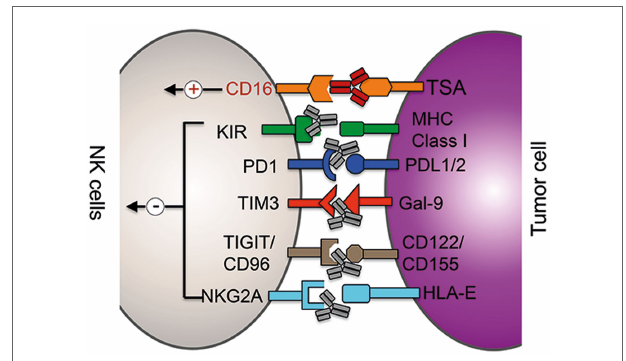
FiGURe 1 | Clinical and preclinical therapies augmenting NK cells function . mAb (gray)-mediated blockade of the interaction between inhibitor receptors (in black) expressed on NK cells with the respective ligands on tumor cells (or suppressor cells) results in increased cytolytic potential of NK cells. ADCC therapy: binding of mAbs (red) to tumor-specific antigens (TSA) results in the activation of NK cells via the activation of the activating receptor CD16